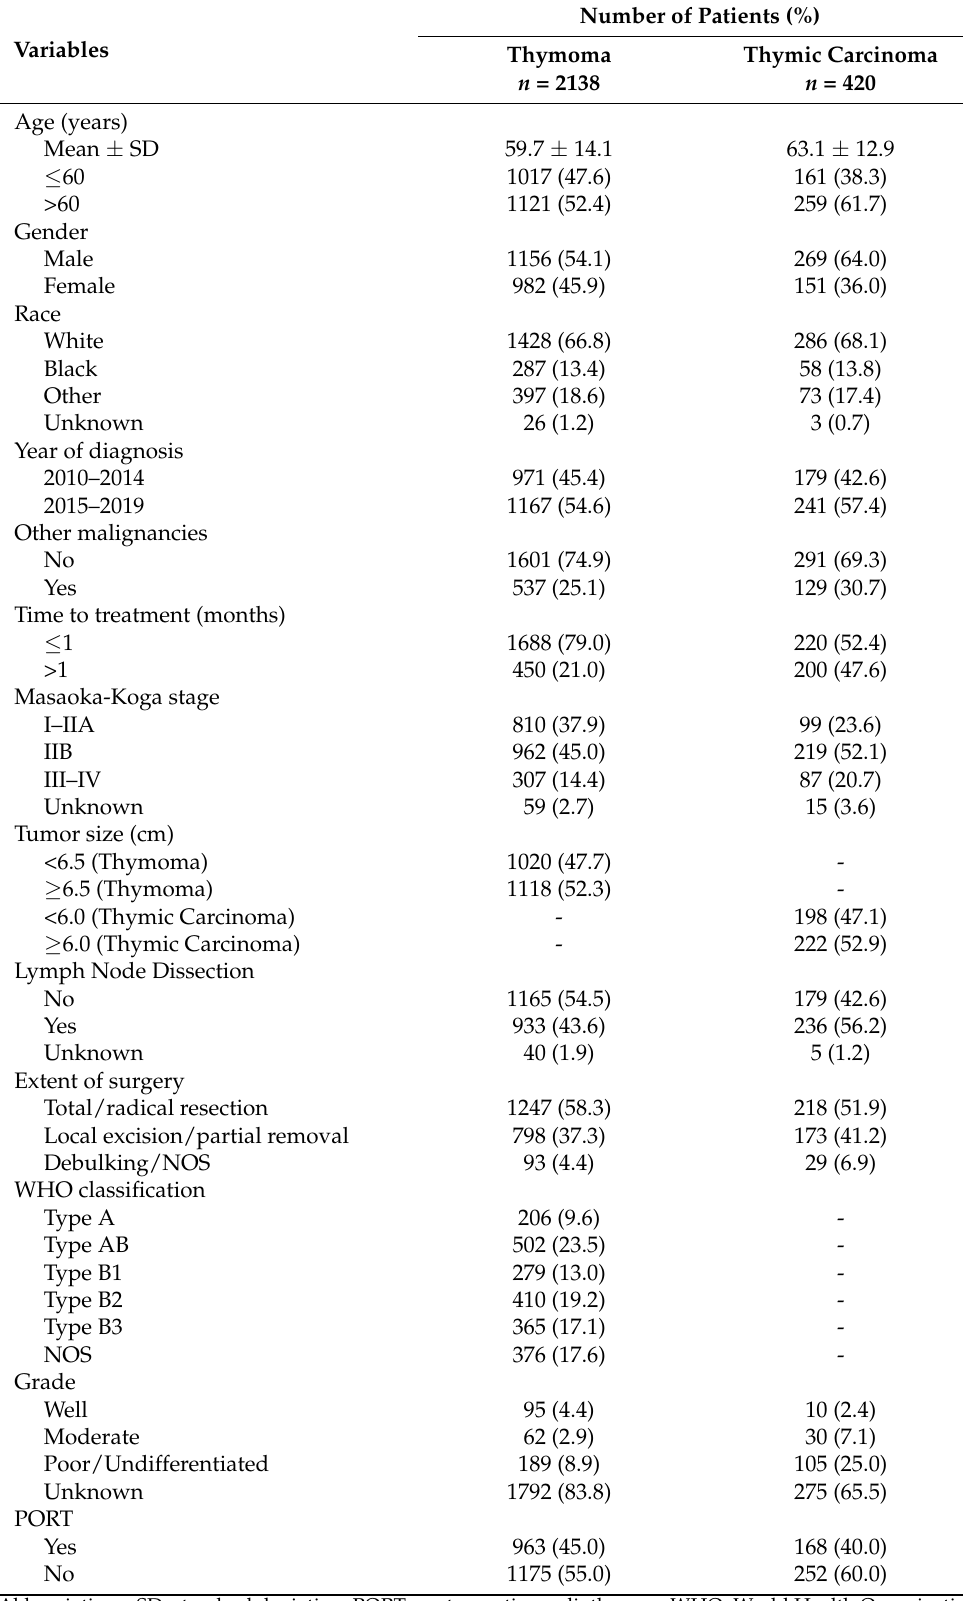
Table 1. Characteristics of thymoma and thymic carcinoma in the SEER database.